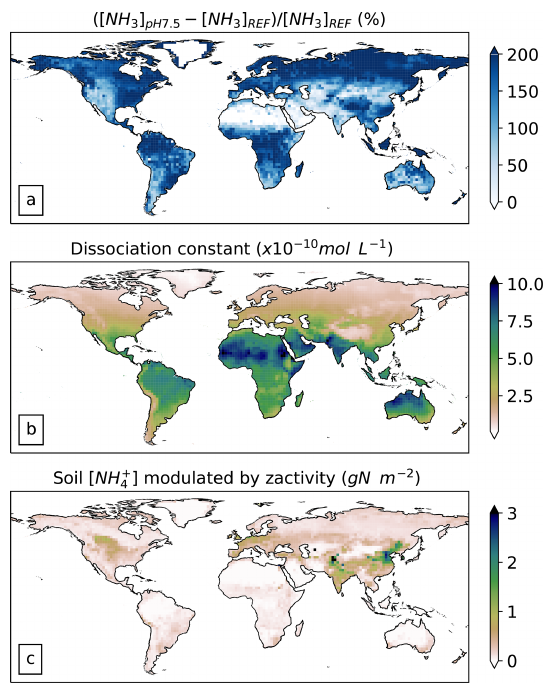
Figure 8. (a) The relative anomaly of gaseous ammonia in soil be- tween the pH 7 . 5 simulation and the reference simulation as a per- ( aq ) /NH 3 ( aq ) dissociation constant from centage (%). (b) The NH + 4 the reference simulation (molL − 1 ). (c) The soil NH 4 concentration modulated by the z activity parameter (gNm − 2